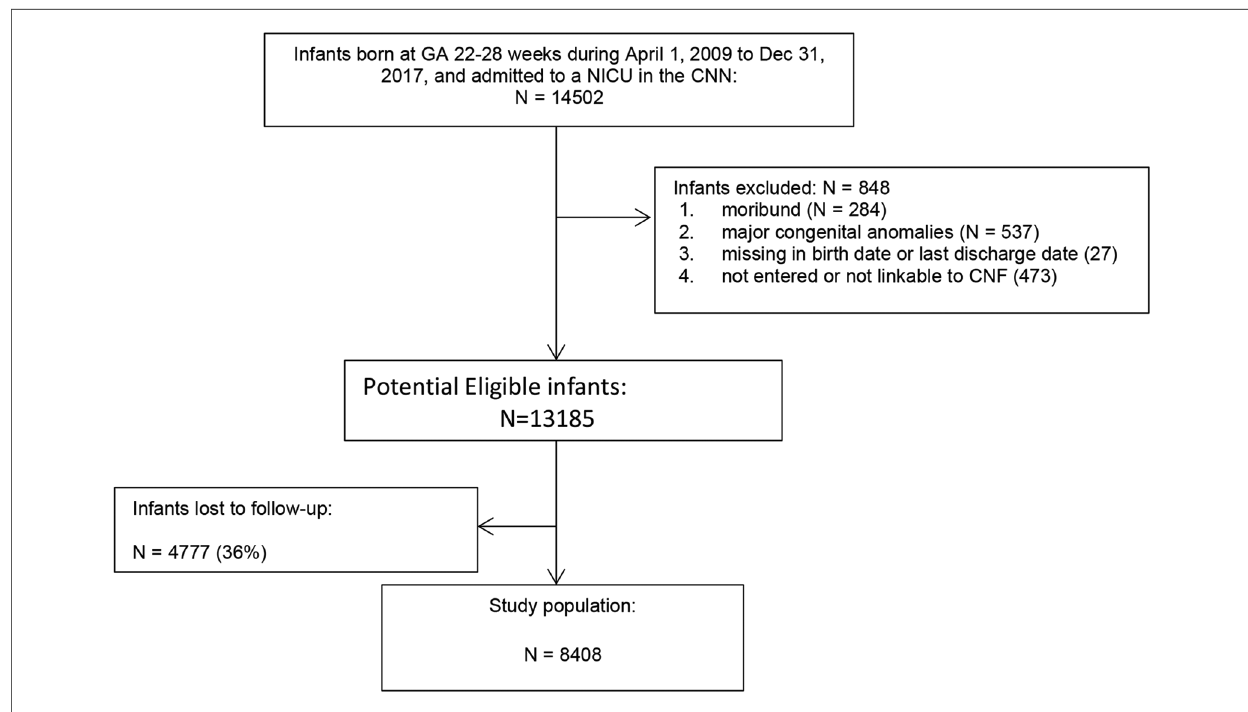
FIGURE 1 Flow chart diagram for study